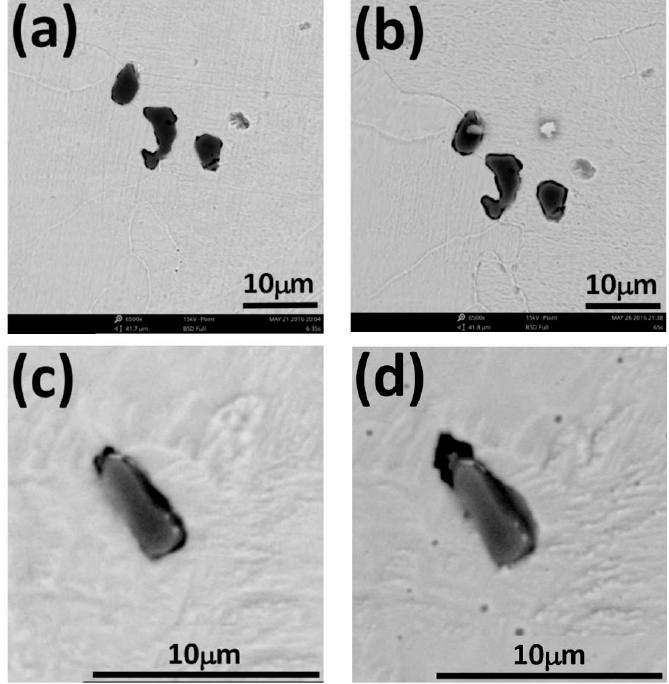
Figure 9. Other types of Al 2 O 3 inclusion corrosion morphology. ( a ) 35 s; ( b ) 65 s; ( c ) 105 s; ( d ) 155 s.